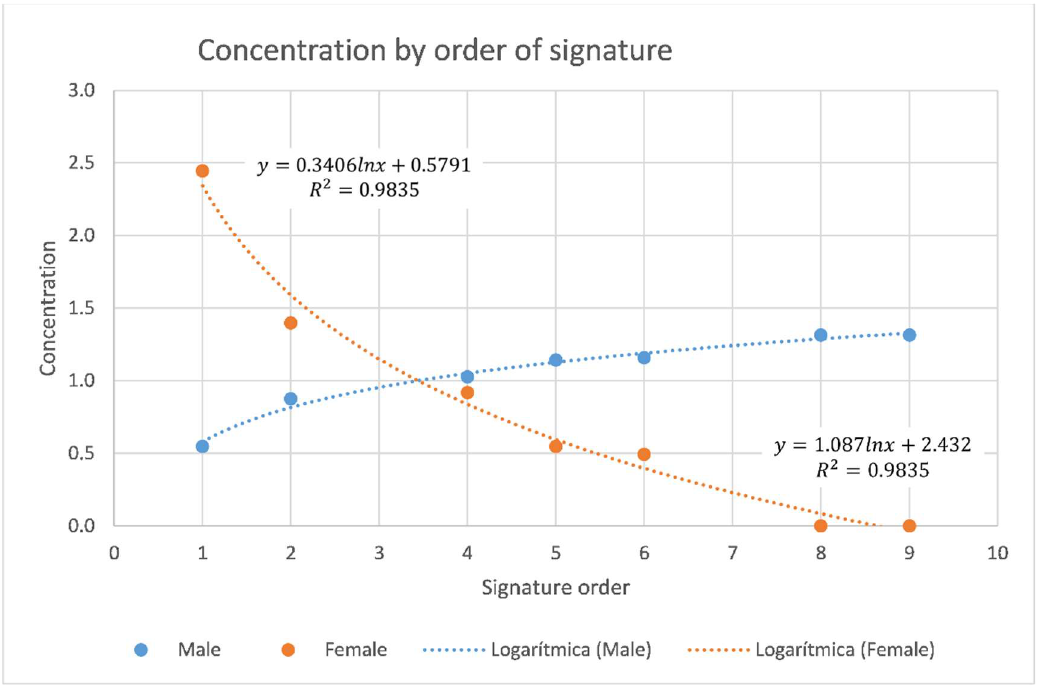
Figure 7. Concentration of men and women according to their position in the byline order.